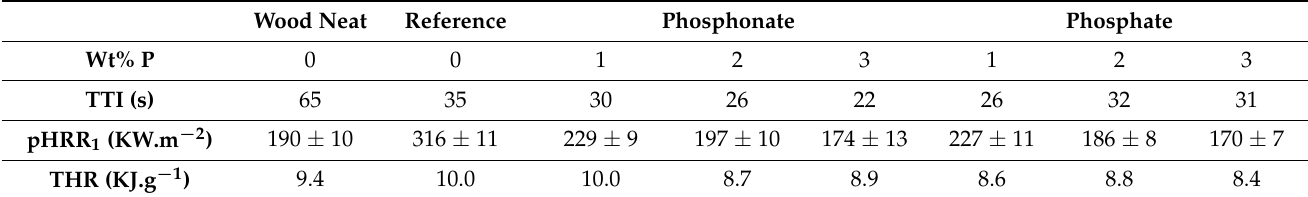
Table 5. Cone calorimeter analyses of phosphorylated cardanol reactive diluent alkyd